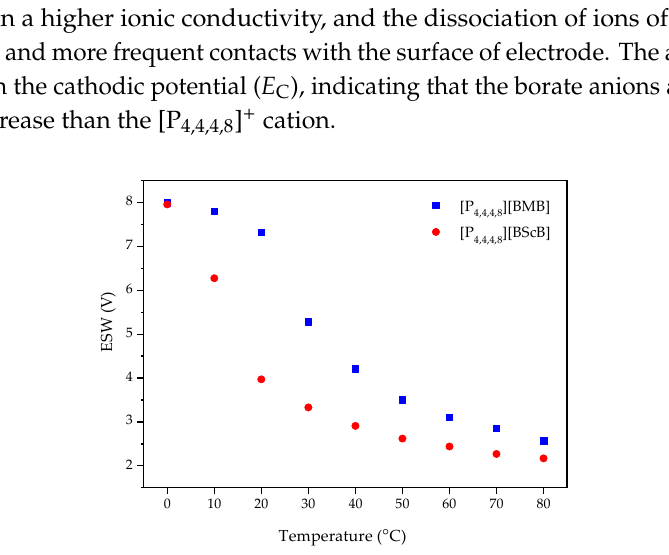
Figure 6. LSV of [P 4,4,4,8 ][BScB] at a GC electrode, different temperatures, and a scan rate of 20 mV s −1 .